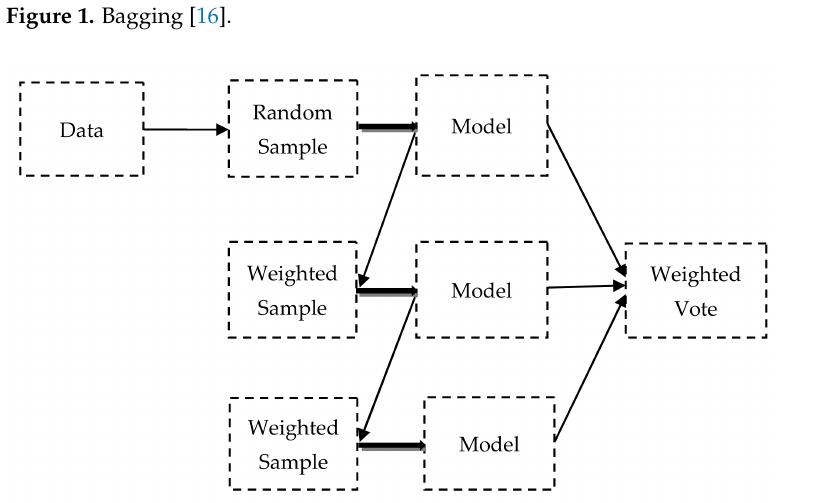
Figure 2. Boosting